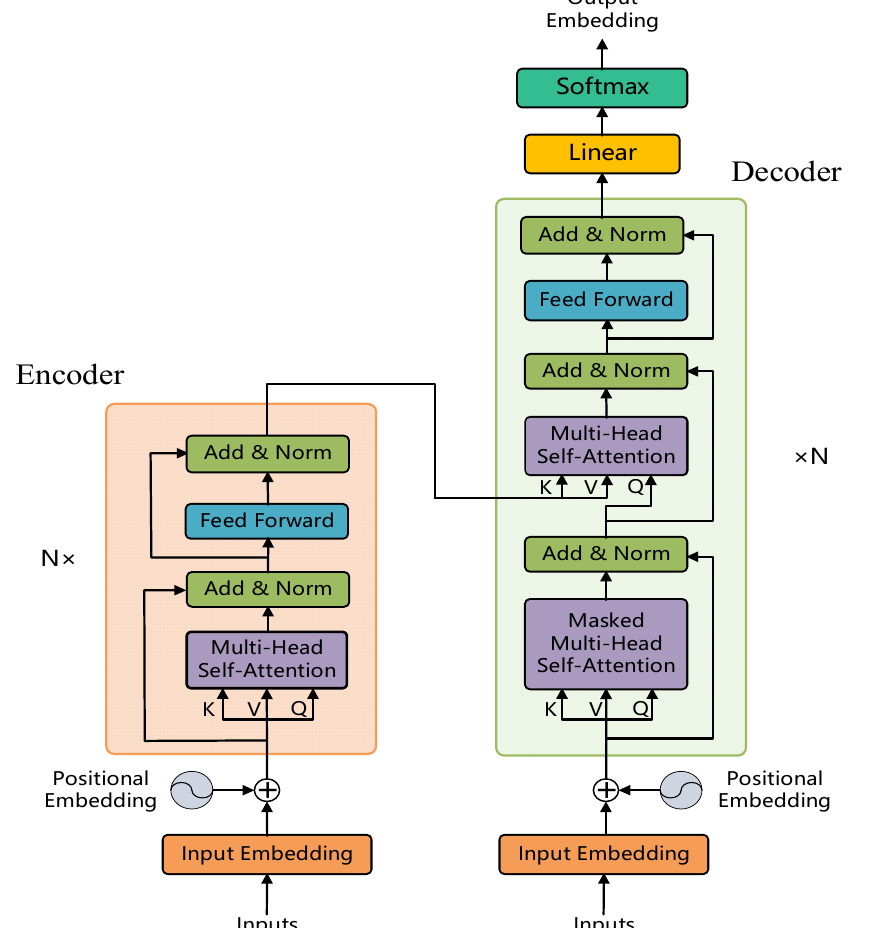
Figure 3. Architecture of the transformer model.